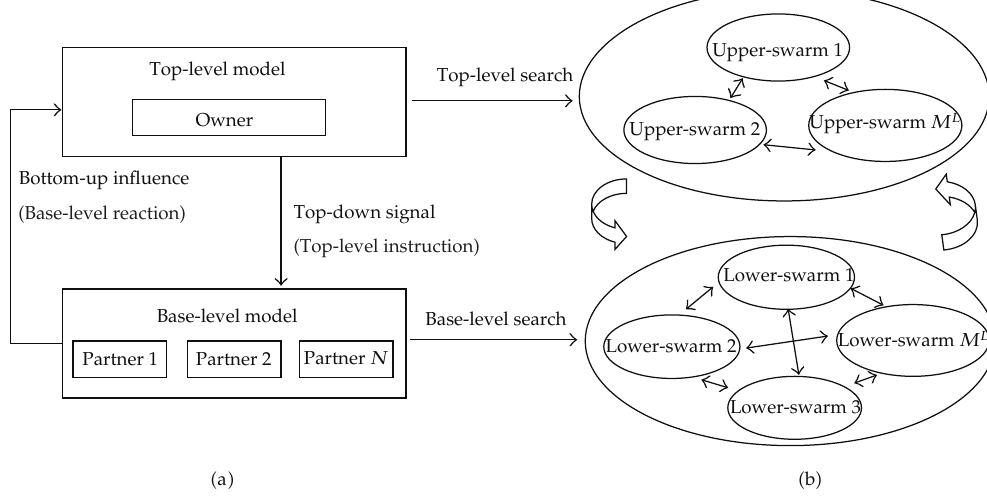
Figure 10: The exchange of information between (cid:3) a (cid:4) the owner and partners, (cid:3) b (cid:4) the upper-swarms, and